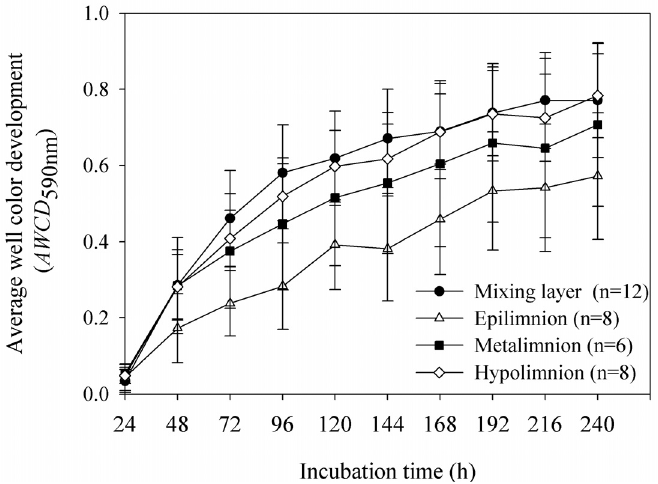
Figure 2. Kinetics of average well color development ( AWCD 590nm ) curve of bacterial communities of each water layer in the Jinpen Dirking Water Reservoir, China. The data shown are the means and standard error (S.E.). “ n ” represents the number of samples in each layer. There were no significant differences with depth during the mixing period (data not